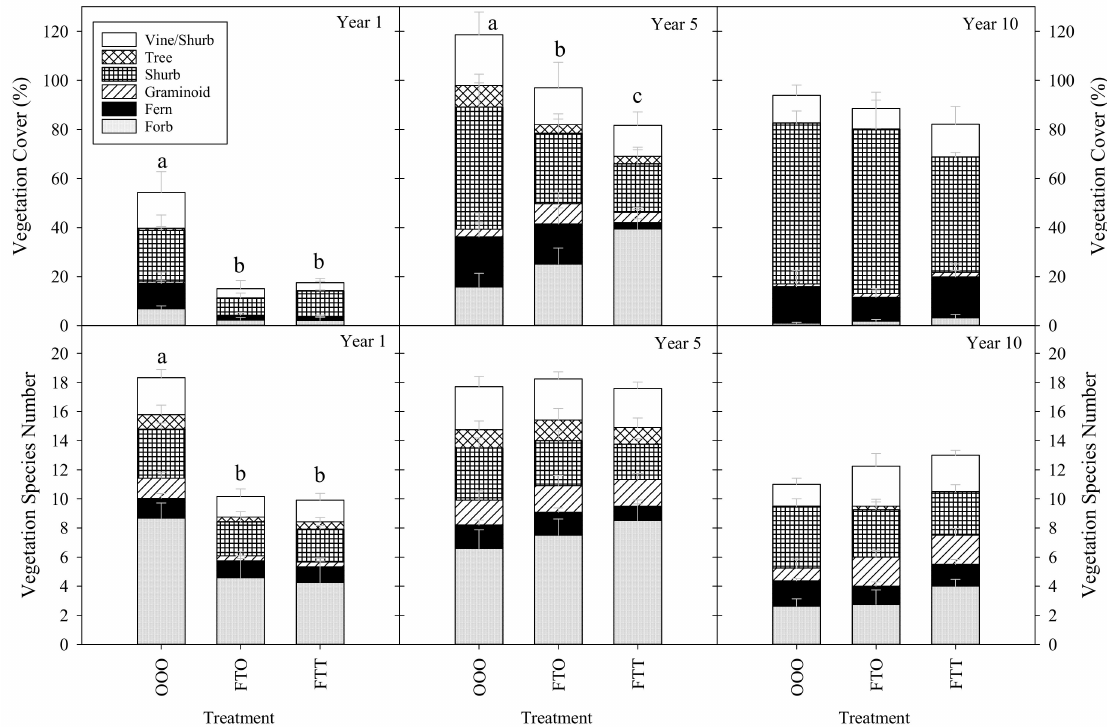
Figure 2. Vegetation community composition during years 1, 5, and 10 (left to right). Summed vegetation cover (top panel) and average species number per plot (bottom panel) are presented by growth habit for each vegetation management regime. When significant di ff erences were found, letters over each bar represent significant di ff erences for total cover (top) or species number (bottom) at a significance level of α = 0.05. Treatment descriptions are provided in Table